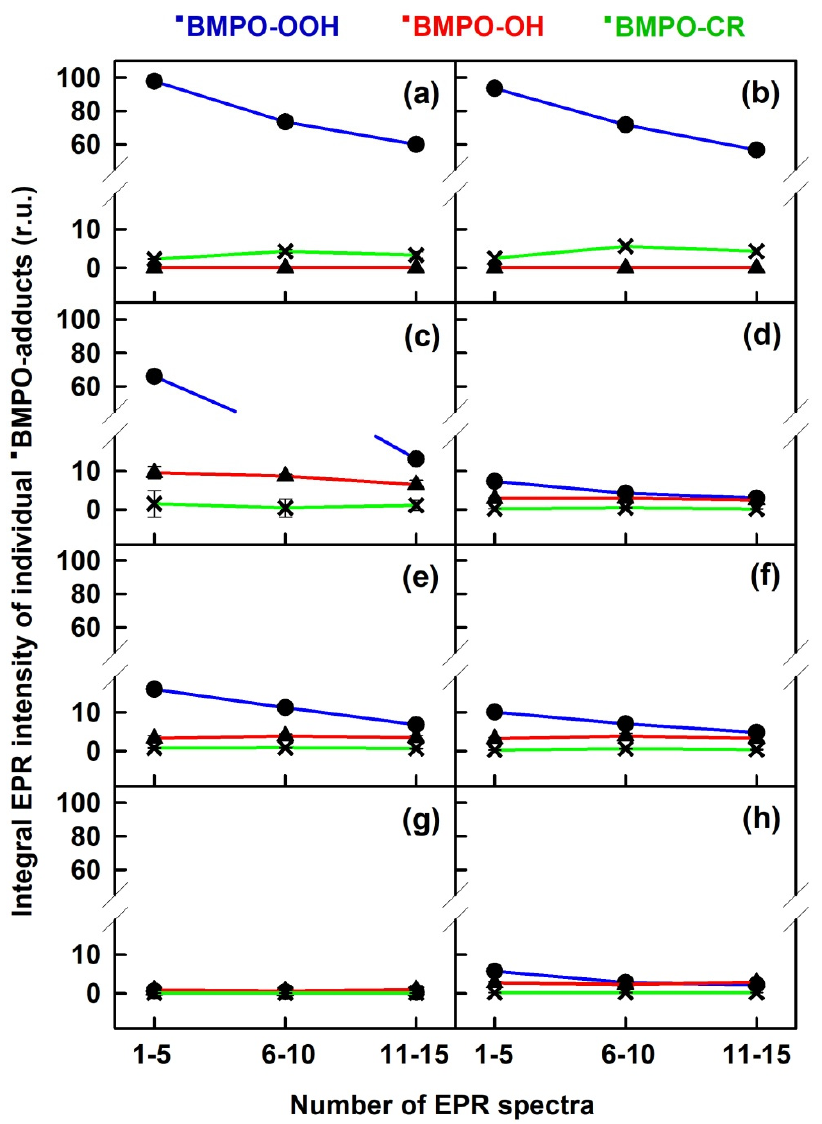
Figure 4. Comparison of integral EPR intensity of individual BMPO-adducts elucidated from the simulation of experimental EPR spectra. The first to fifth accumulated spectra (1–5; 1.7–5.2 min after sample preparation; see Figure 1), the sixth to tenth accumulated spectra (6–10; 5.2–8.7 min